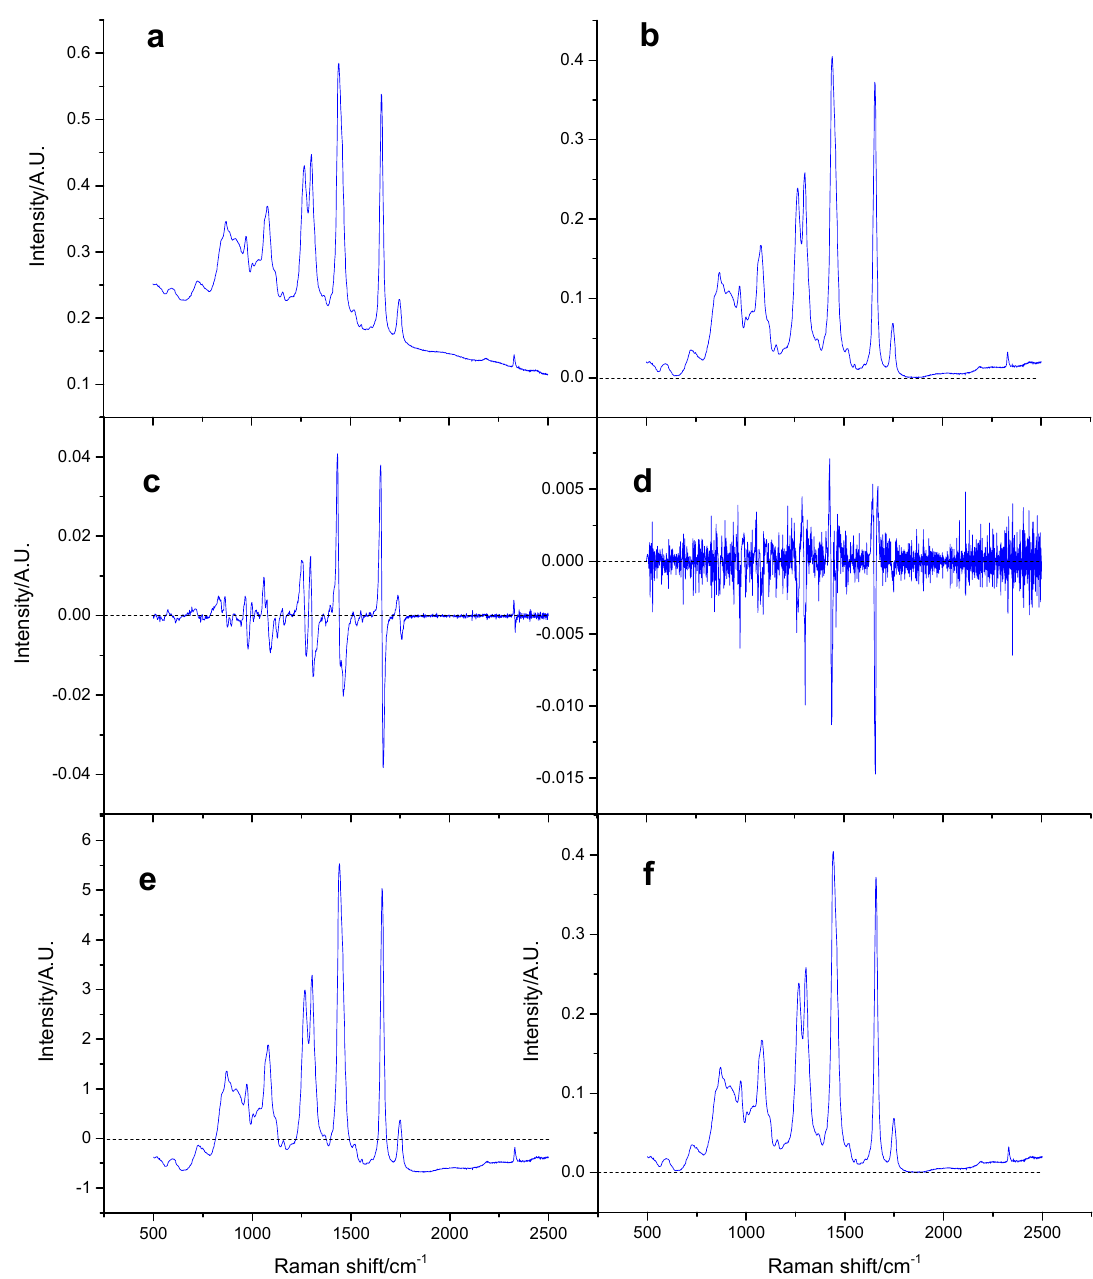
Figure 3. The Raman spectra of samples obtained using different pretreatments: ( a ) the original spectrum; ( b ) the spectrum after baseline fitting; ( c ) the spectrum after applying the first derivative; ( d ) the spectrum after applying the second derivative; ( e ) the spectrum after applying standard normal variate (SNV); ( f ) the spectrum after applying MSC.